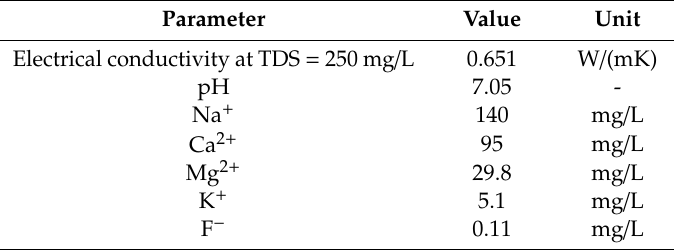
Table 2. Chemical composition of water used in the present